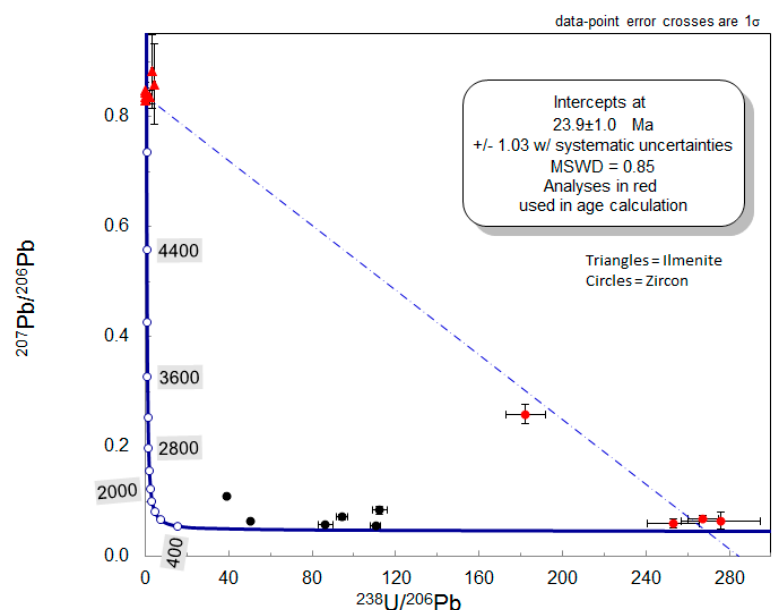
Figure 11. Concordia diagram showing zircon plots (red spots) used to constrain a concordia age of the four youngest zircons within the Mong Hsu host ruby. Age measurements on two baddeleyite megacrysts from the site (grey spots) are shown, but relationships to Mong Hsu ruby are uncertain.